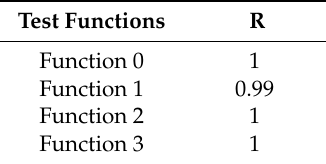
Table 1. Correlation coe ffi cients obtained for the test functions.